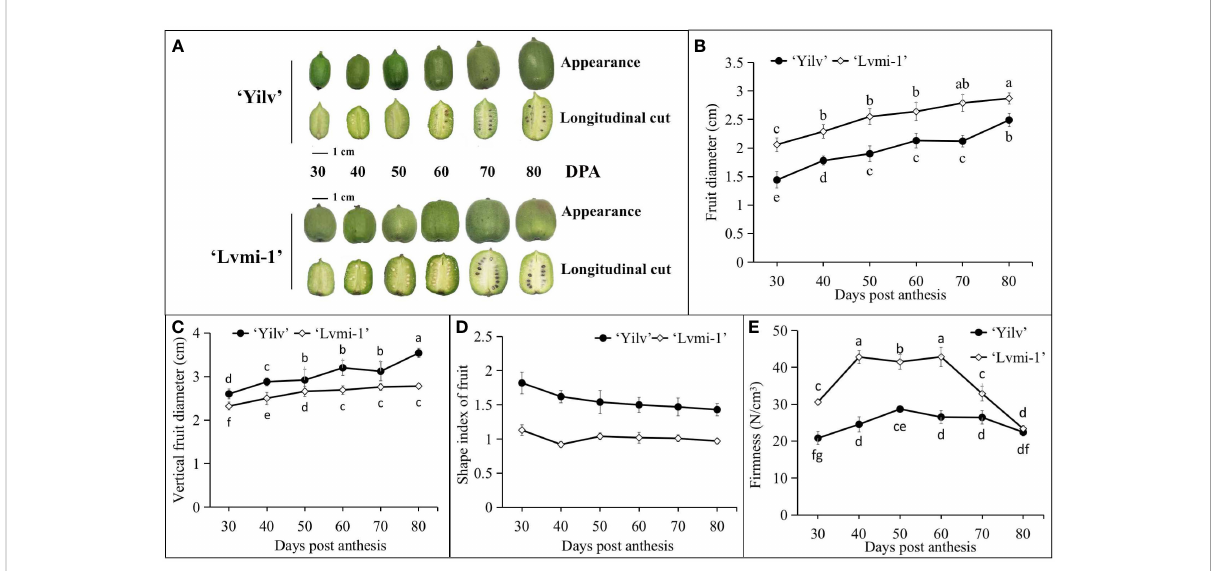
FIGURE 1 Morphological characteristics of the ‘ Yilv ’ and ‘ Lvmi-1 ’ fruits. (A) Fruit phenotypes during development and maturity. (B) Diameter of fruit changes during fruit development. (C) Changes of vertical diameter of fruit in different developmental stages. (D) Shape index of fruit during development. (E) Firmness changes in different developmental stages of ‘ Lvmi-1 ’ and ‘ Yilv ’ fruit. Data were represented by the mean values ± standard deviation. Different letters indicated signi fi cant difference at the p ≤ 0.05